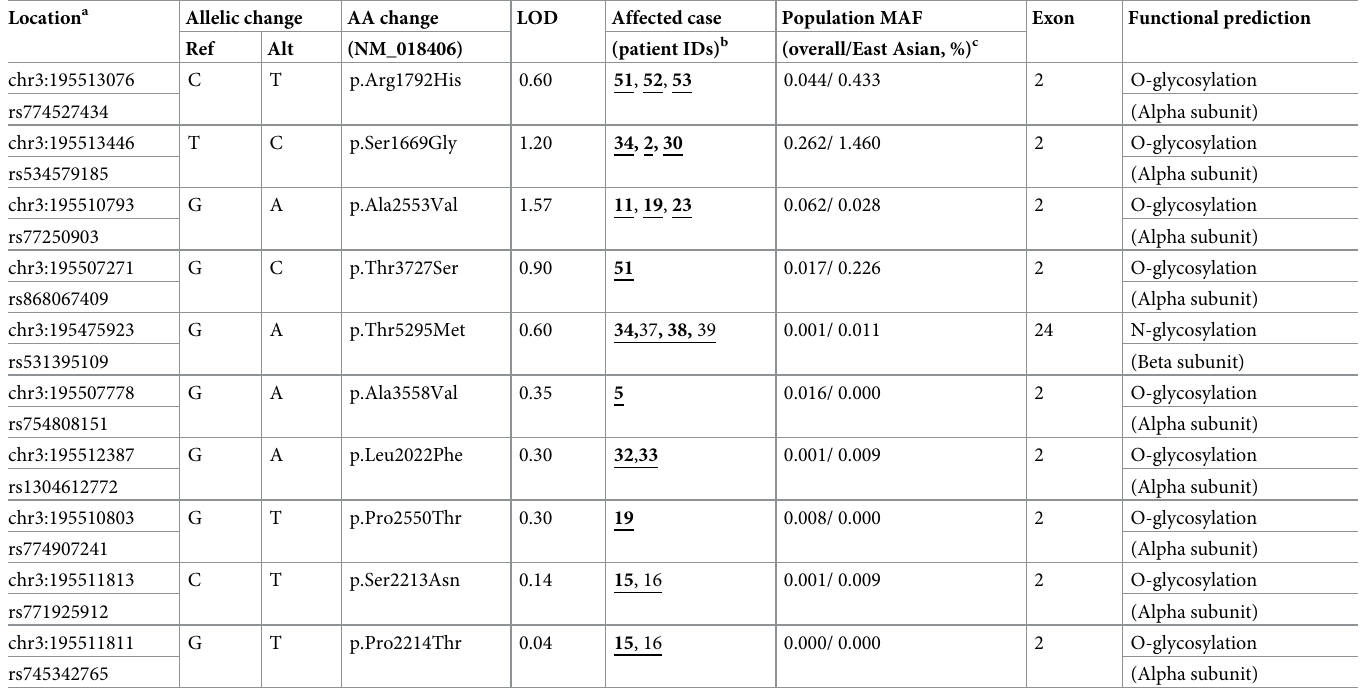
Table 2. Characteristics of the germline MUC4 variants associated with gastric cancer by linkage analysis in the 14 studied families. Location a Allelic change AA change